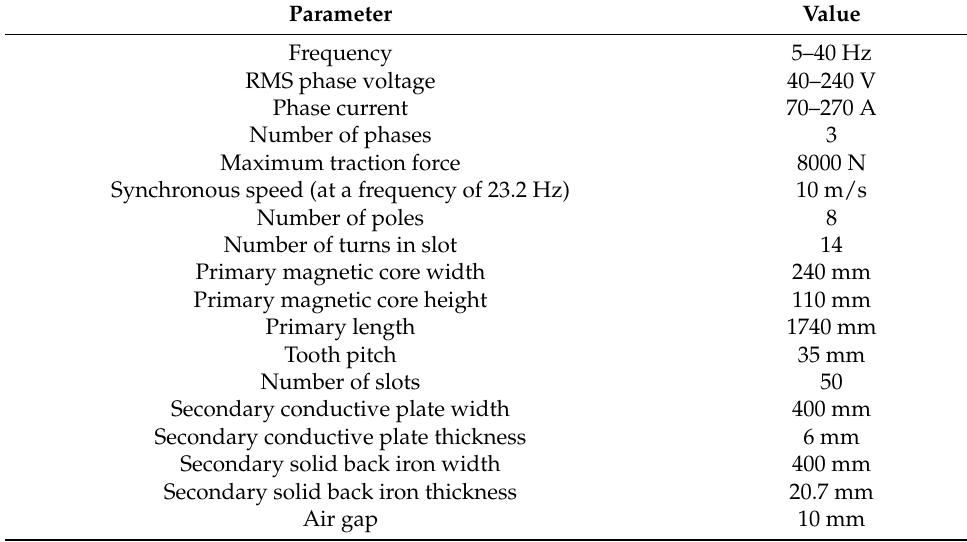
Table 4. Parameters of the traction LIM of the urban transportation system.